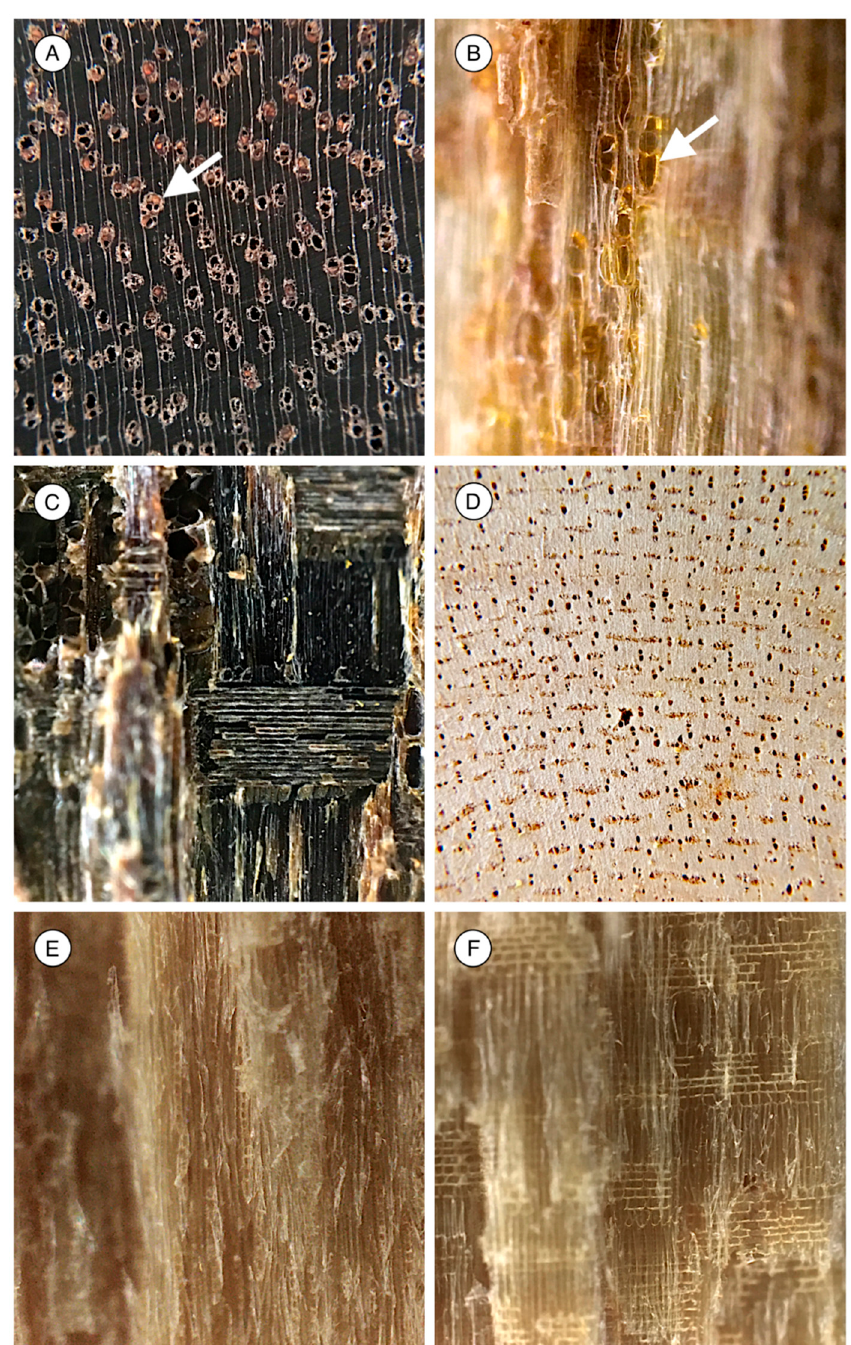
Figure 4. Elements visible with 24× and 400× lenses in hardwoods. Aniba rosodora Ducke, ( A ) Tyloses (400× lens). ( B ) Oil cells in axial parenchyma (400× lens). ( C ) Rays with one row of upright and/or square marginal cells (400× lens). Aquilaria malaccensis Lam. ( D ) Diffuse included phloem (24× lens). ( E ) Uniseriate rays (400× lens). ( F ) Rays with one row of upright and/or square marginal cells (400× lens).